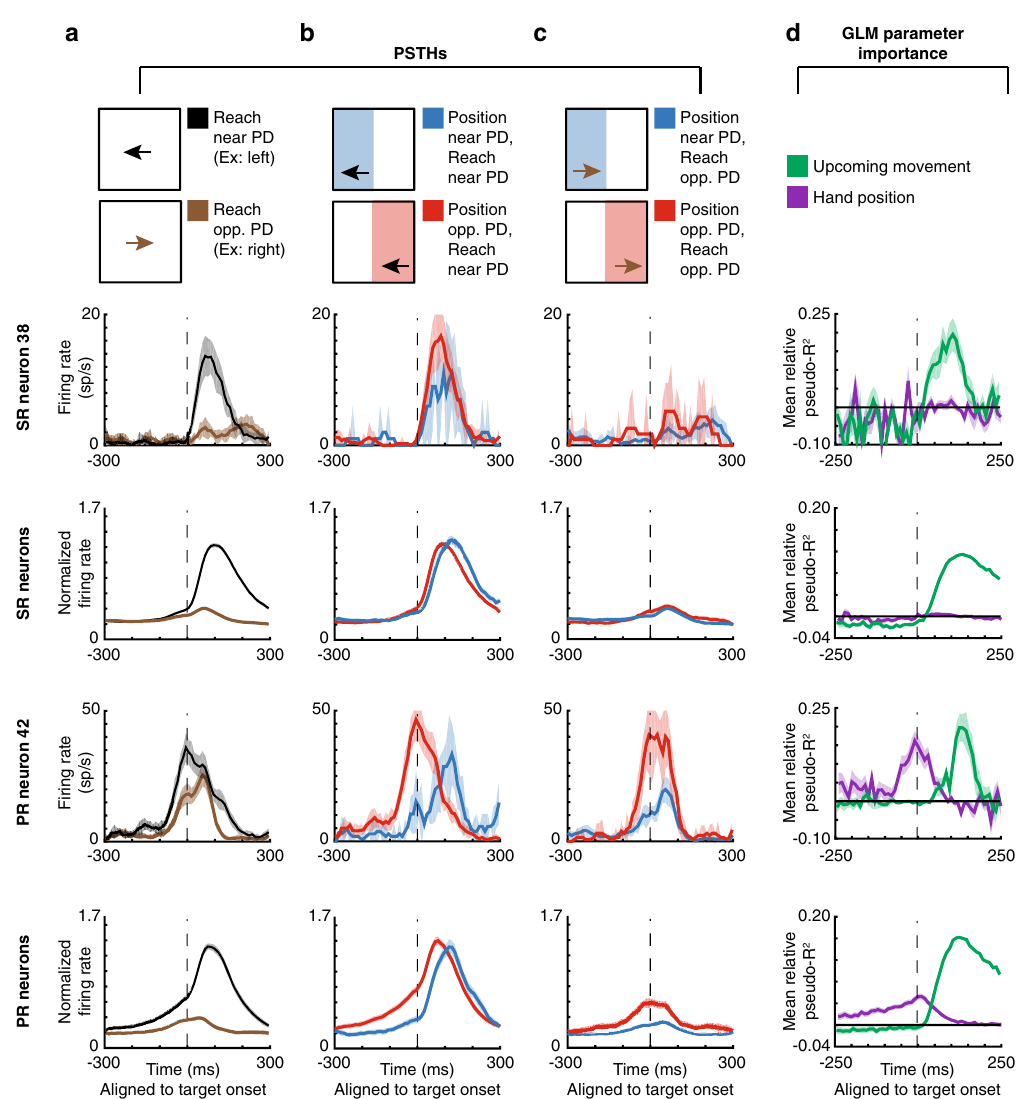
Fig. 3 PMd PSTHs and GLM results. First row: A selected-response (SR) neuron. Second row: Normalized averages of SR neurons. Third row: A potential- response (PR) neuron. Bottom row: Normalized averages of PR neurons. a – c Peristimulus time histograms (PSTHs) for PMd neurons, aligned to target onset. Shaded areas represent SEMs. a PSTHs of reaches near the preferred direction (PD; black) vs. opposite the PD (brown). b PSTHs of reaches near the PD, with a starting hand position near the PD (lower probability of moving near the PD; blue) vs. a position opposite the PD (higher probability of moving near the PD; red). c PSTHs of reaches opposite the PD, with a starting hand position near the PD (blue) vs. a position opposite the PD (red). d We utilized a generalized linear model (GLM) to control for confounds in the PSTHs, including different distributions of starting positions, upcoming movements, and previous movements. Here, we show the importance of parameters in the GLM, across time, for PMd neurons. We show mean relative pseudo- R 2 over time, of the upcoming movement (green) and hand position (purple) covariates. For the 2nd and bottom row, shaded areas represent SEMs across neurons. For individual neurons, shaded areas represent the standard deviation across